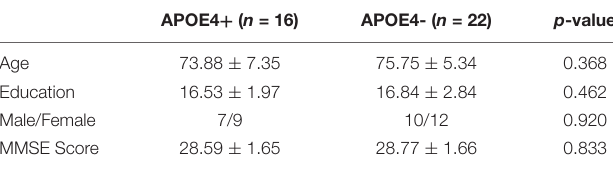
TABLE 4 | Demographic characteristics of NC dataset.